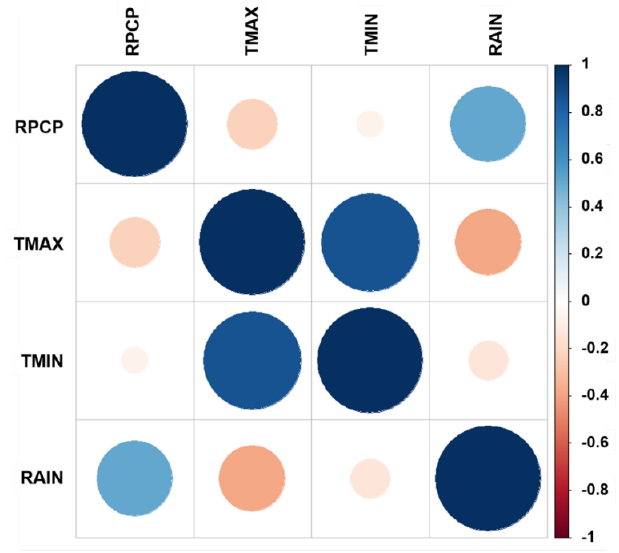
Figure 2. Correlation coefficients for weather prediction. PRCP-the amount of precipitation; TMAX-the maximum temperature for a day; TMIN-the minimum temperature for a day; RAIN-true and false for raining.